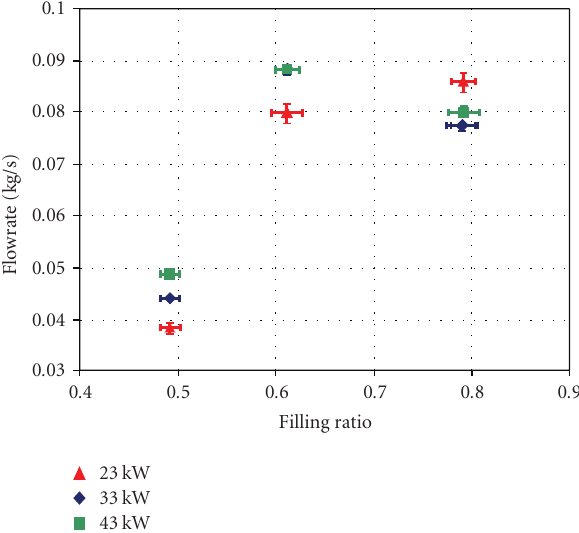
Figure 4: E ff ects of filling ratio and electrical power on pool condenser outlet subcooling (without heat losses compensation) [14].